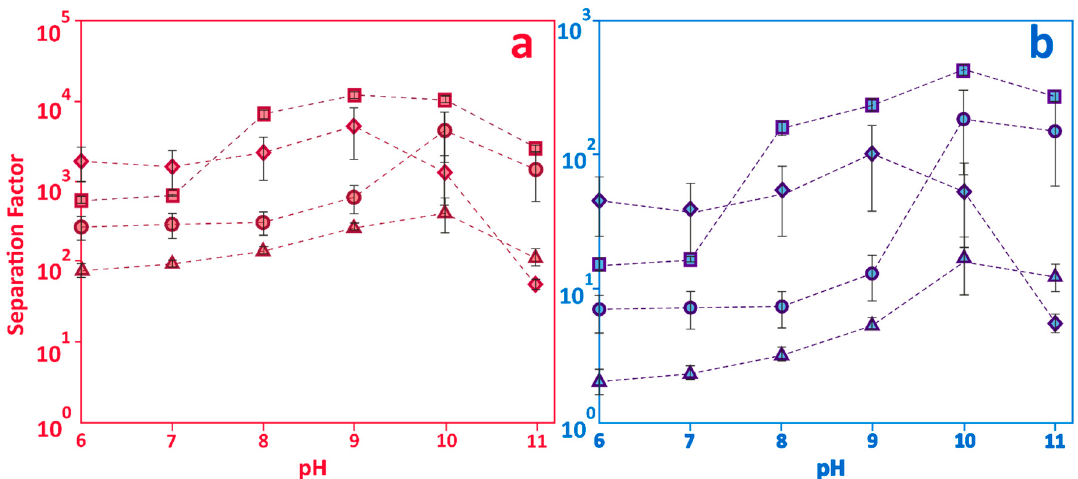
Figure 5. Separation factor of ( a ) Zn: [Zn] / [Fe] (squares), [Zn] / [Al] (diamonds), [Zn] / [Mg] (circles), [Zn] / [Ca] (triangles) and ( b ) Cu: [Cu] / [Fe] (squares), [Cu] / [Al] (diamonds), [Cu] / [Mg] (circles), [Cu] / [Ca]